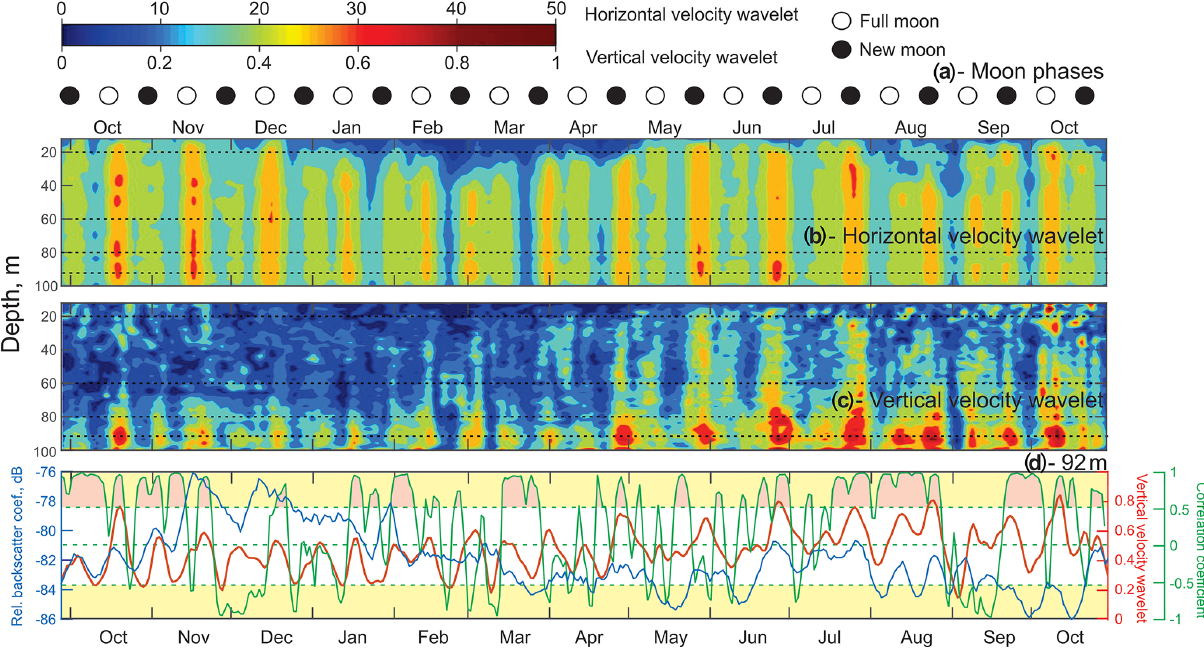
Figure 5. Time series of (a) lunar phases for 2016–2017. (cid:13) : Full moon. • : New moon. (b, c) The absolute value of the wavelet power spectrum for the time series of horizontal velocity (b) and vertical velocity (c) computed for the semidiurnal frequency band (12h) as a function of depth. (d) The correlation coefficient (green line) between time series of VBS (blue line) and the vertical velocity wavelet (red line) at 92m of depth. Yellow shading identifies the correlation coefficient levels exceeding ± 0 . 53, which are statistically significant for the 95% confidence level. Pink shading identifies the events during which this statistically significant correlation was observed.